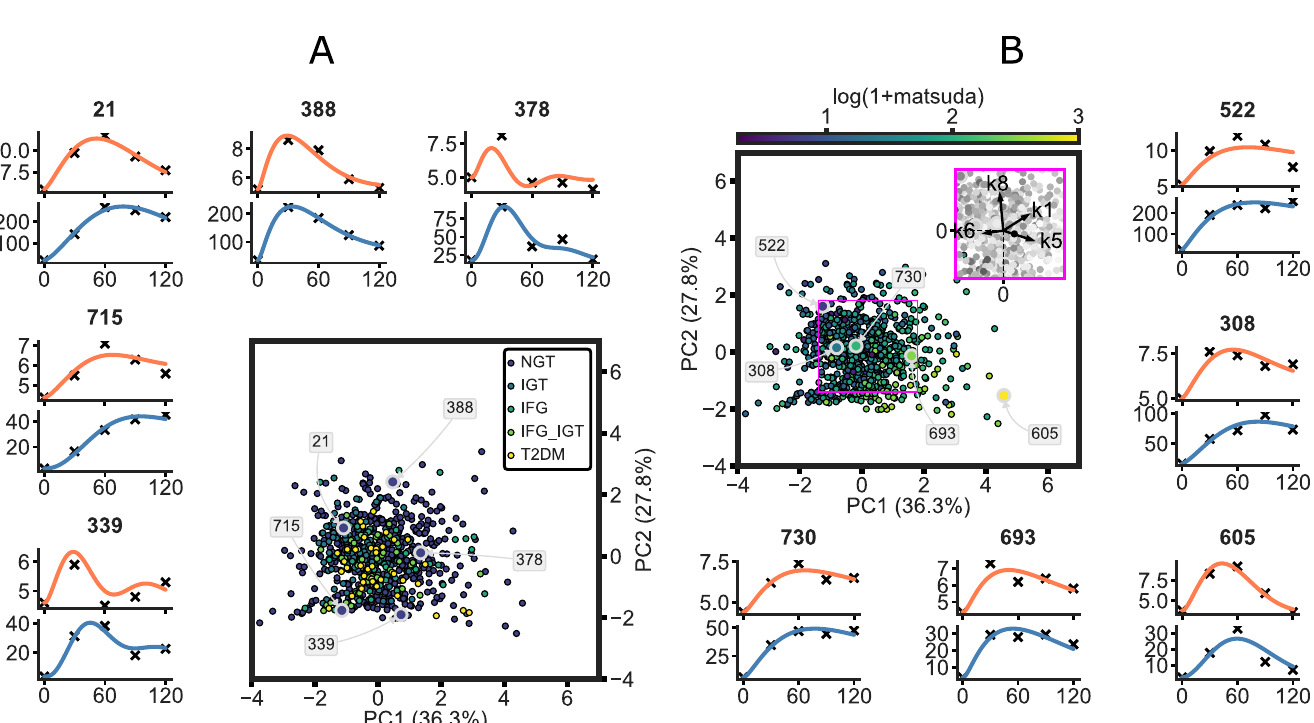
Fig 6. Individual parameter sets in the parameter space of the model colored by the ADA diabetes criterion (A) and the Matsuda index (B) after reduction to 2d via principal component analysis. The personalized model simulations of five participants’ responses are highlighted (individuals 21, 388, 378, 715, 339 on panel A and 522, 308, 730, 693, 605 on panel B). Orange and blue lines correspond to glucose and insulin model simulation, while crosses represent measured data. The loading vectors of k1, k5, k6, and k8 are shown in the purple insert in panel B.